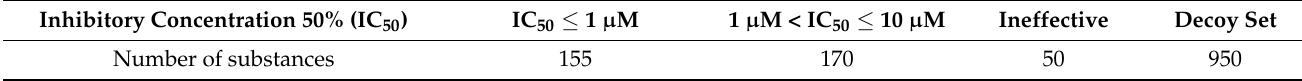
Table 10. Test set of pharmacophore